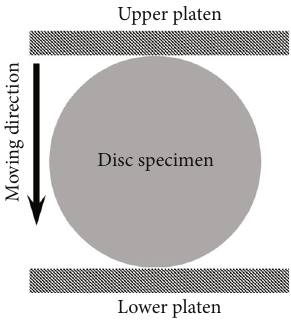
Figure 2: Schematic diagram of the BTS test in the